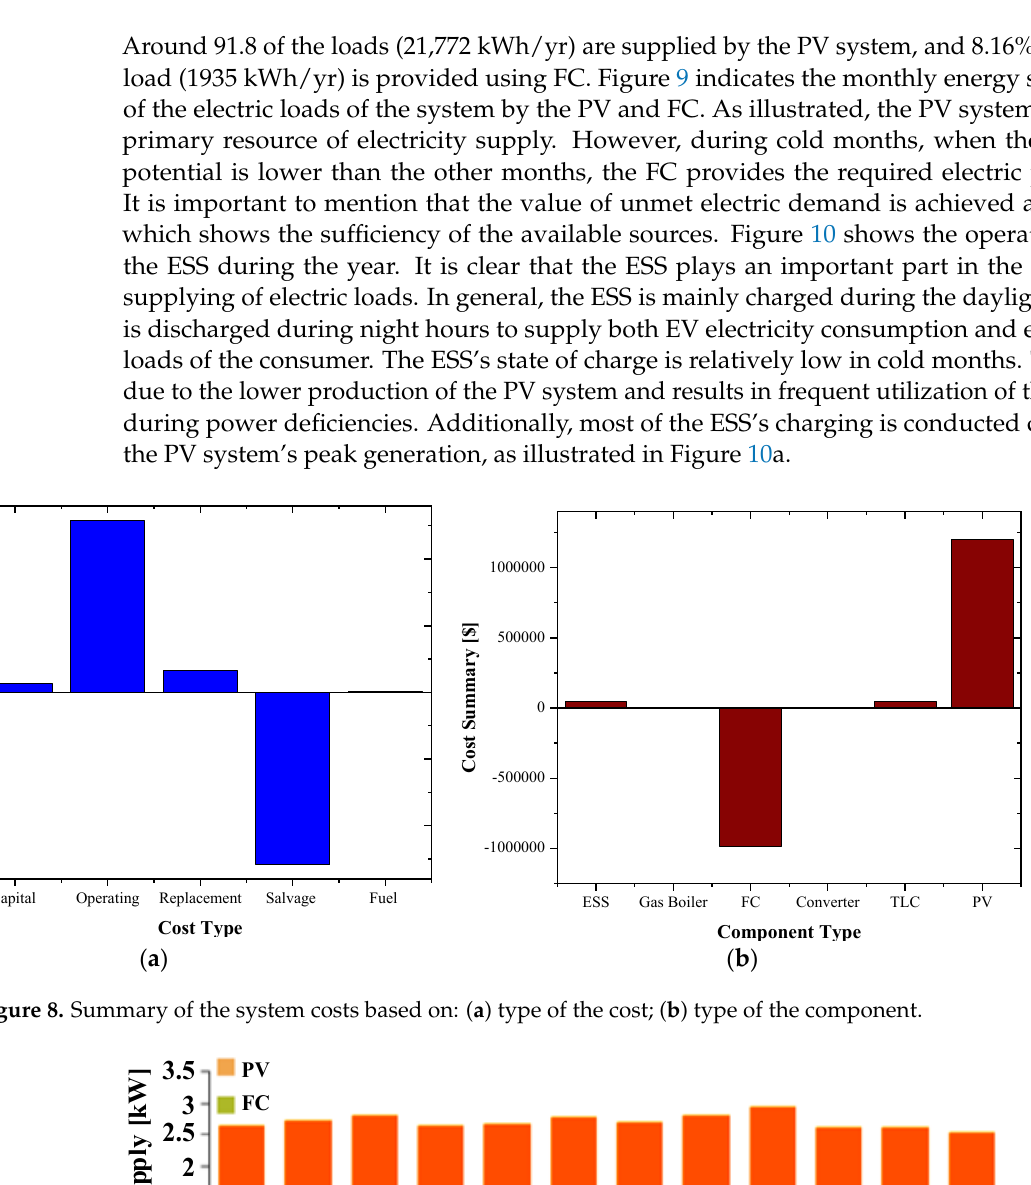
( b ) Figure 10. The ESS state of charge: ( a ) in hourly scale; ( b ) in monthly scale. The thermal demand of the system is largely provided by the gas boiler 68.6% (5861 kWh/yr), TLC 16.8% (1431 kWh/yr), and FC 14.6% (1247 kWh/yr). This shows the signifi- cance of TLC in the thermal power provision, which has a higher ratio of supply than the FC. Figure 11 shows the output power of thermal power suppliers, namely, gas boiler, FC, and TLC. As indicated in Figure 11a, the gas boiler provides greater amounts of thermal power to the loads in cold months. This is because the thermal load consumption is higher in cold months (Figure 6a). In addition, the boiler is operated in most hours of a day, but larger amounts of power are produced during peak periods. As shown in Figure 11b, the FC is usually operated during night hours and mainly in peak demands. This is more visible in cold months of the year. On the other hand, the TLC mostly provides thermal mostly in the peak generation of the PV system. Therefore, excess electricity by solar en- ergy is used for supplying the thermal demand of the system. According to the results, the boiler is operated 7956 h/yr, the FC is operated 529 h/yr, and the TLC is operated 419 h/yr.